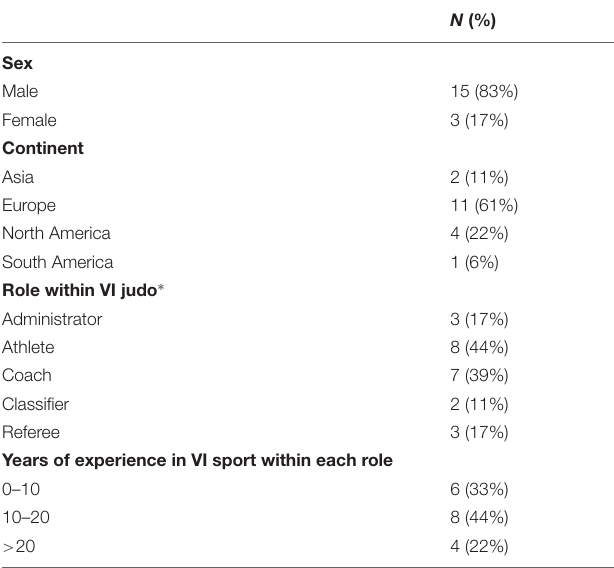
TABLE 1 | Participant